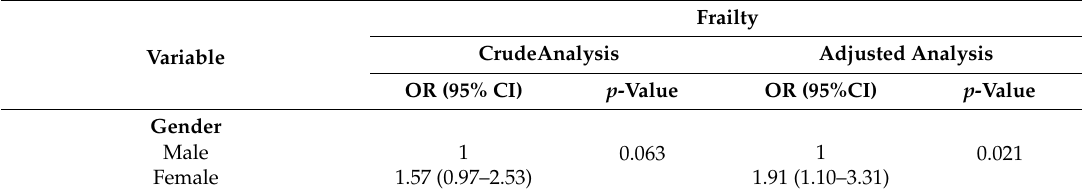
Table 3. Association of sociodemographic variables, health indicators and sedentary behaviour with